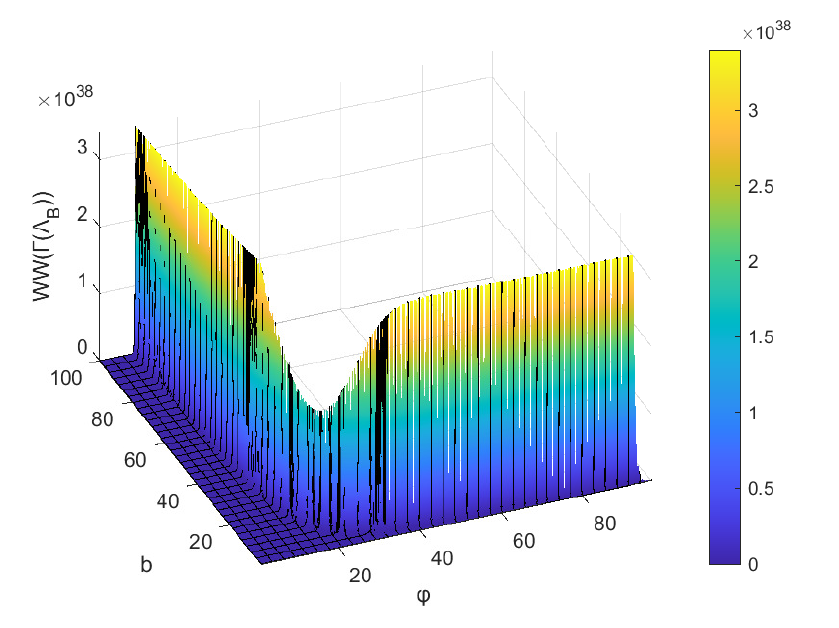
Figure 3. Hyper-Wiener index of Γ ( Λ (cid:66) )